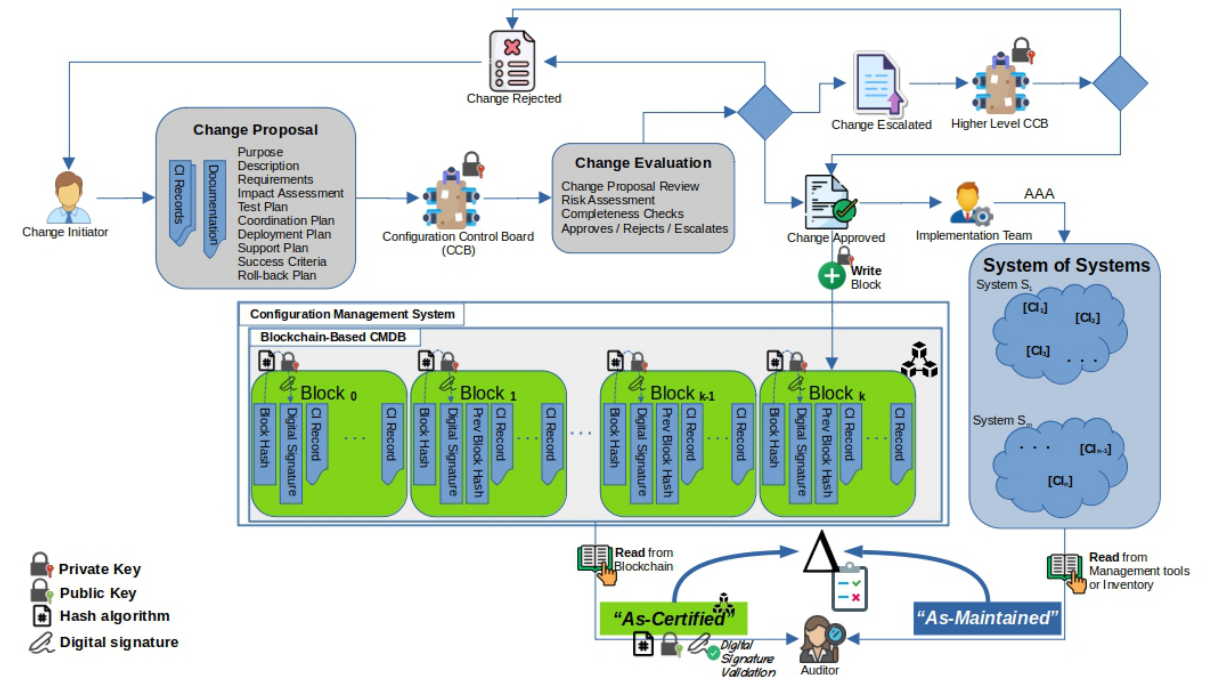
Figure 5. Flowchart of the operating